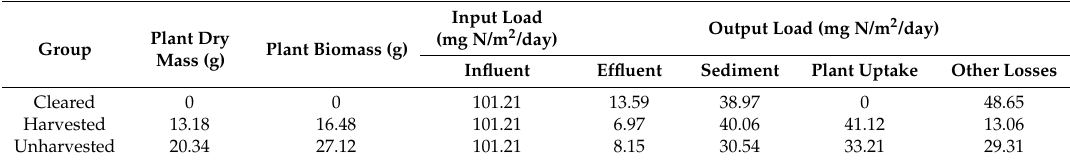
Table 2. Nitrogen mass balance in different groups through the experiment.